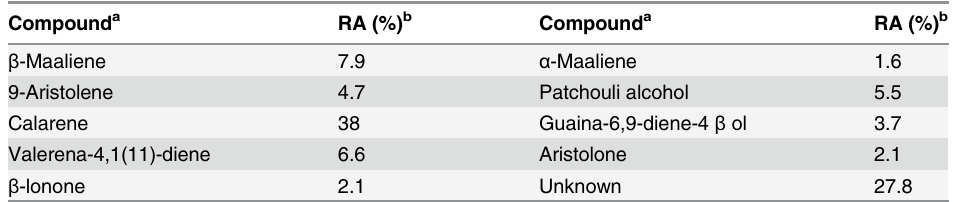
Table 1. Major chemical composition of volatile oil from NRR.